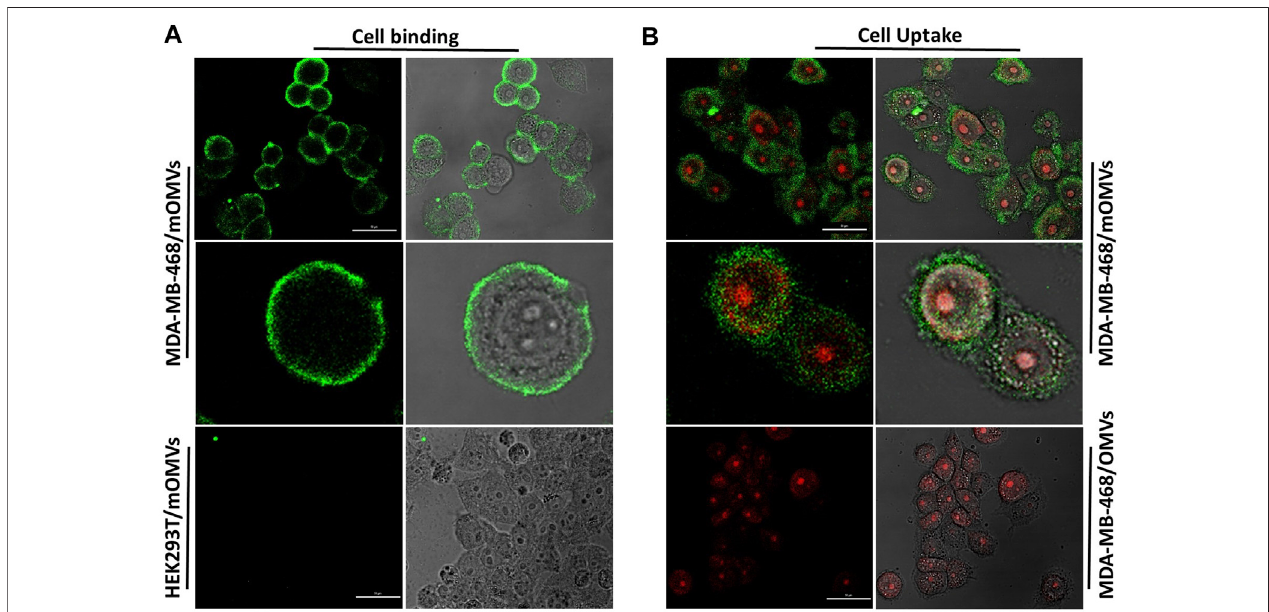
FIGURE5| Cellular (A) bindingand (B) uptakeoftheaf fi EGFR -OMVs analyzedbyconfocal microscopy.HEK293T and MDA-MB-468 cellswere incubated with the af fi EGFR -OMVs (modi fi ed OMVs: mOMVs) for 2 h at 4 ° C. No attachment was seen on HEK293T cells following incubation with the af fi EGFR -OMVs. Af fi EGFR -OMVs were internalized intothe MDA-MB-468 cells after 2 h of incubation at 37 ° C, while no internalization was observed using OMVs into the MDA-MB468 cells. Cells were stained with anti-af fi body antibody and FITC- conjugated rabbit anti-goat IgG. Scale bar in un-zoomed pictures represents 50 μ